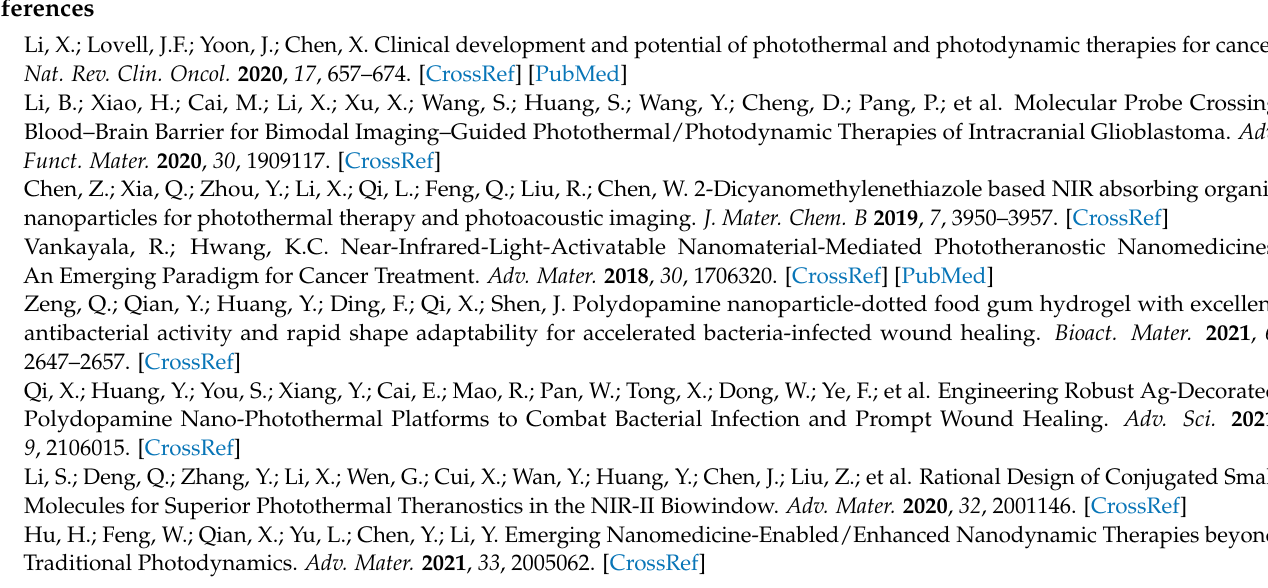
Figure S2. 1 H NMR of DPP polymer in CDCl 3 ; Figure S3: (a) Images of three nanoparticles in water. (b) TEM image of Ir nanoparticles. (c) TEM image of DPP nanoparticles; Figure S4: The absorption spectra of DPP-Ir nanoparticles before and after irradiation; Figure S5: Linear regression equation of H 2 O 2 standard curve; Figure S6: Tumor weight measurements of mice after various treatments. * p < 0.05, ** p < 0.01, *** p < 0.001; Figure S7: Hemolytic tests after incubation with DPP-Ir nanoparticles for 3